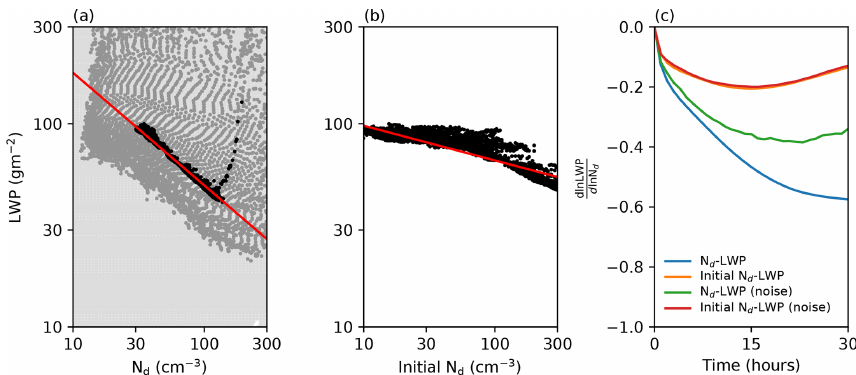
Figure 6. Temporal evolution of sensitivity assuming a constant flowfield for region A in Fig. 2a. (a) The instantaneous N d –LWP relationship after 3h (grey) and 24h (black) from a distribution of points that have no initial N d –LWP relationship (light grey). (b) The relationship between the initial N d and LWP for the same data. (c) dlnLWP as a function of time measured using the instantaneous relationship (blue) and dln N d initial N d (orange). Green and red are these relationships with Gaussian noise applied to the flowfield evolution. The red and orange lines overlap.